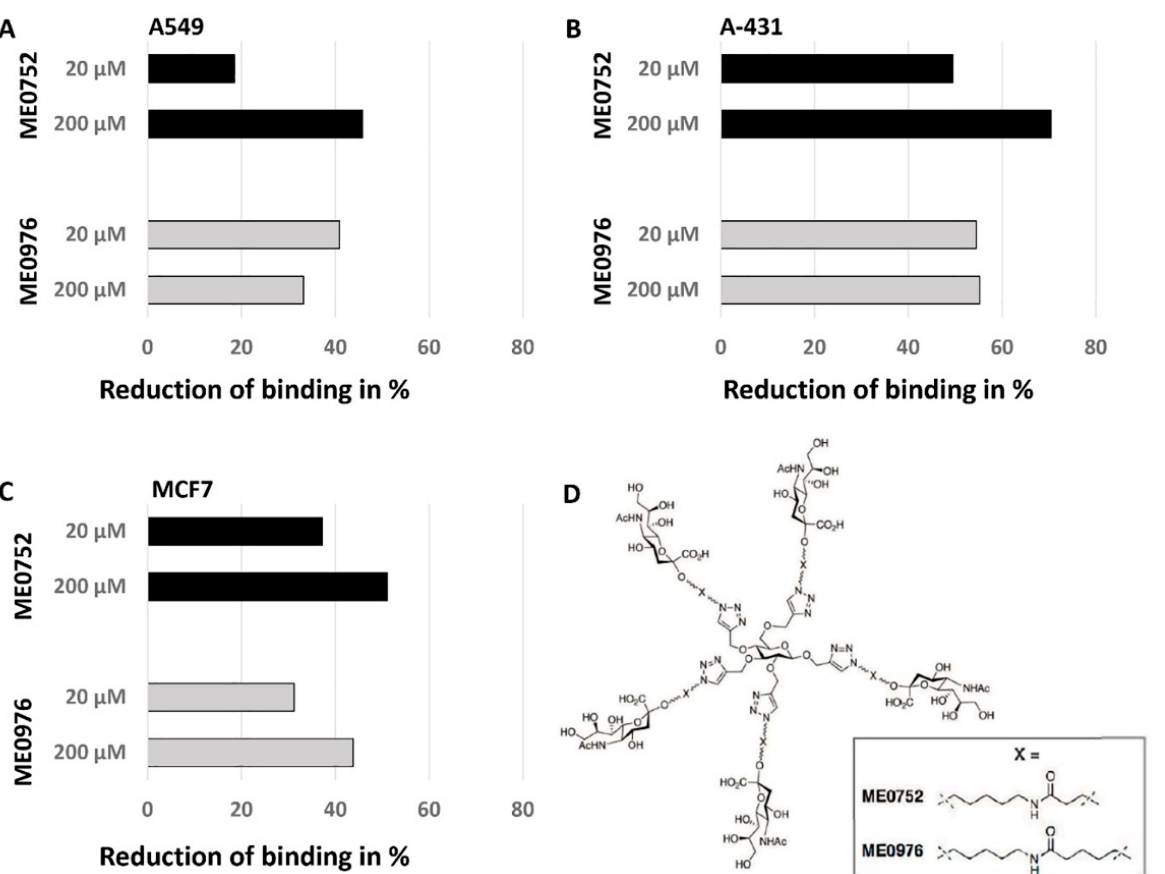
Figure 3. SA-MIPs were pre-incubated with different concentrations of SA conjugates and analyzed with flow cytometry. The reduction in binding compared to SA-MIP binding alone is shown. The SA conjugates ME0752 and ME0976 were added to the SA-MIPs at 20 µM and 200 µM, respectively, and the particles were used thereafter to stain ( A ) A549, ( B ) A-431, and ( C ) MCF7 cells. The chemical structures for ME0752 and ME0976 are shown in ( D ). One representative experiment out of two performed is shown.